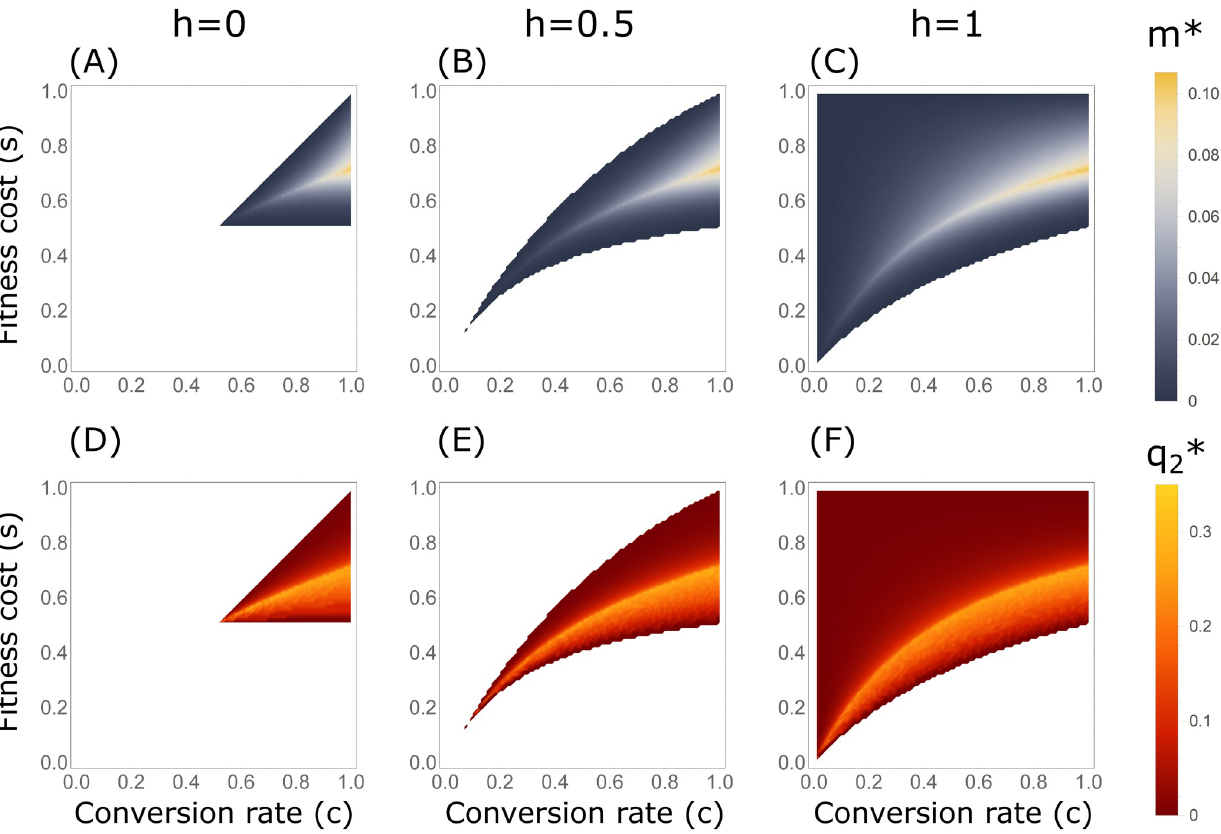
Fig 3. Critical migration thresholds for differential-targeting in the two-deme model. (A–C) Maximal migration rates m � for which a DTE exists. The colored regions denote the configurations for which a DTE exists ( B 2 configurations), and the regions in white denote configurations for which differential targeting of the demes is not possible ( A 1 , A 2 , and B 1 ). Over most of the parameter space, a DTE exists only for low migration rates (in blue), and only in a narrow band do DTEs exist with migration rates above m � = 0.05 (light yellow). (D–F) Maximal gene-drive frequencies in the non-target population, q � values are correlated with m � DTEs. q � 2